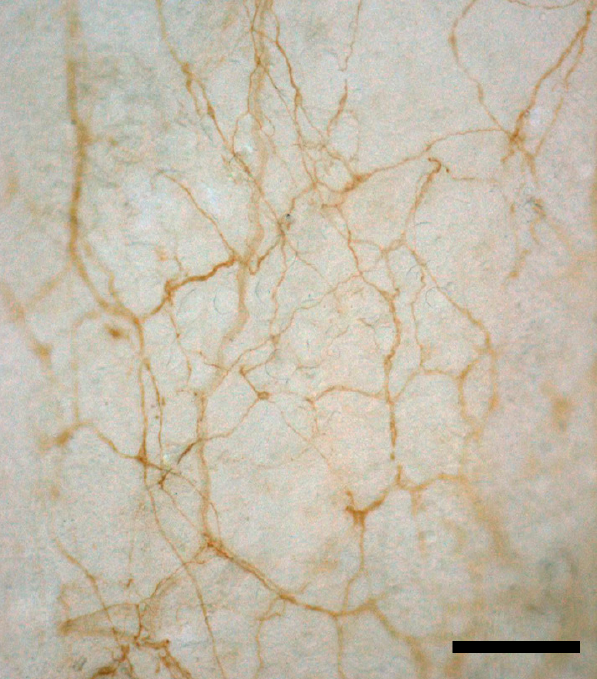
Figure 1. S100 immunohistochemistry reaction of thoracolumbar fascia of the mouse. The reaction shows a dense, thin neural network strongly connected with the extracellular matrix of the fascial tissue and consequently particularly responsive to stretch and tensional variations, highlighting the importance of fascia as a sensory system. Scale bar: 100 µm.